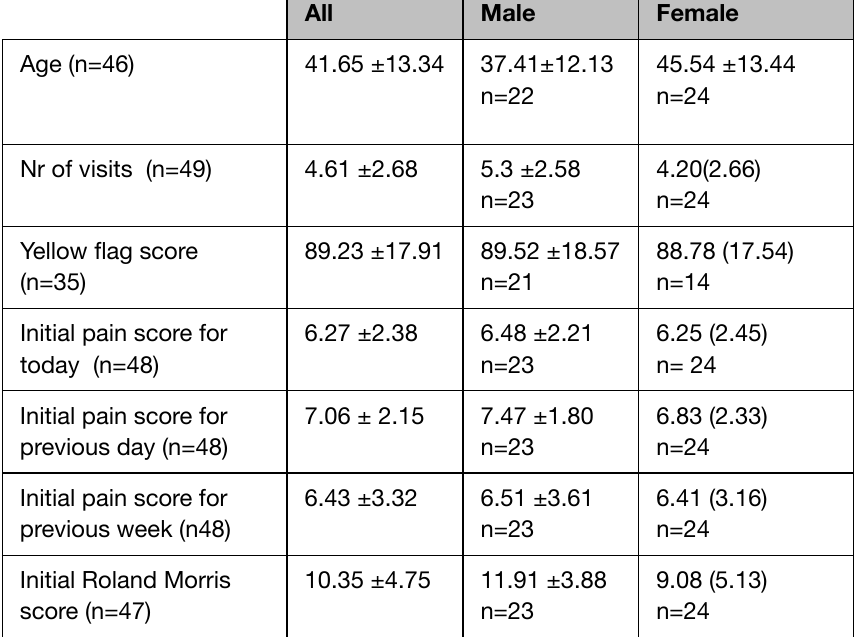
Table 1: Demographic summary and description of initial pain and disability